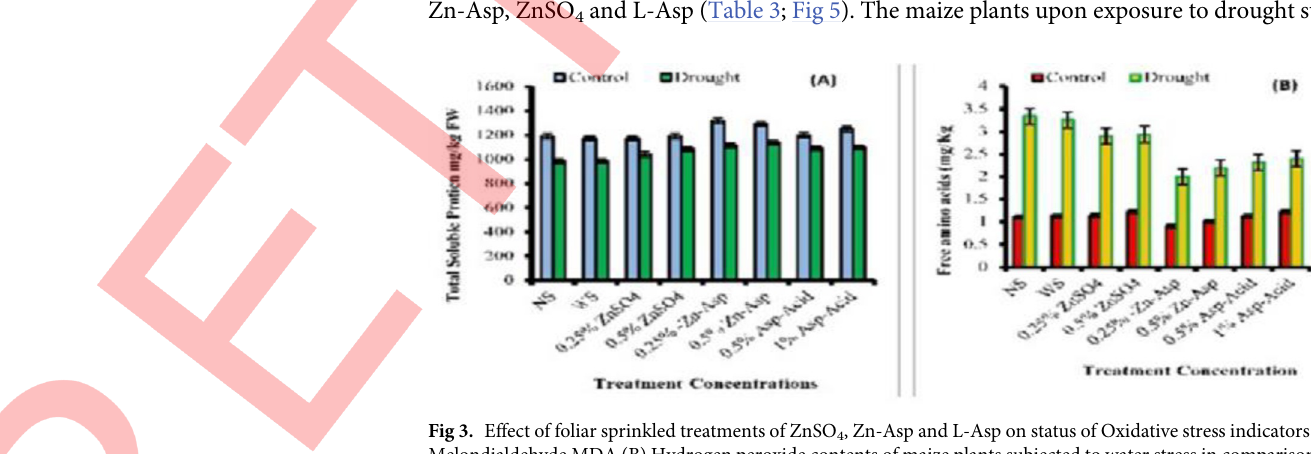
Fig 3. Effect of foliar sprinkled treatments of ZnSO 4 , Zn-Asp and L-Asp on status of Oxidative stress indicators (A) Melondialdehyde MDA (B) Hydrogen peroxide contents of maize plants subjected to water stress in comparison with well watered conditions (mean ± SE; n =